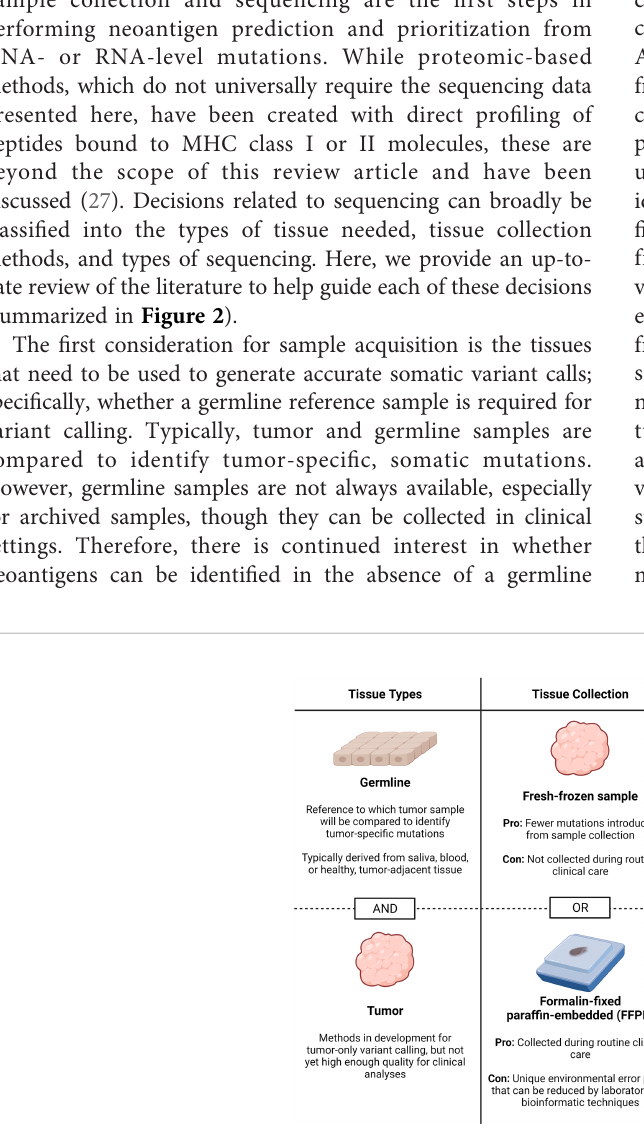
FIGURE 2 | Sample collection and sequencing considerations. Here we describe considerations for obtaining sequencing data for neoantigen prediction including tissues needed, tissue collection method, and sequencing types. Figure created with